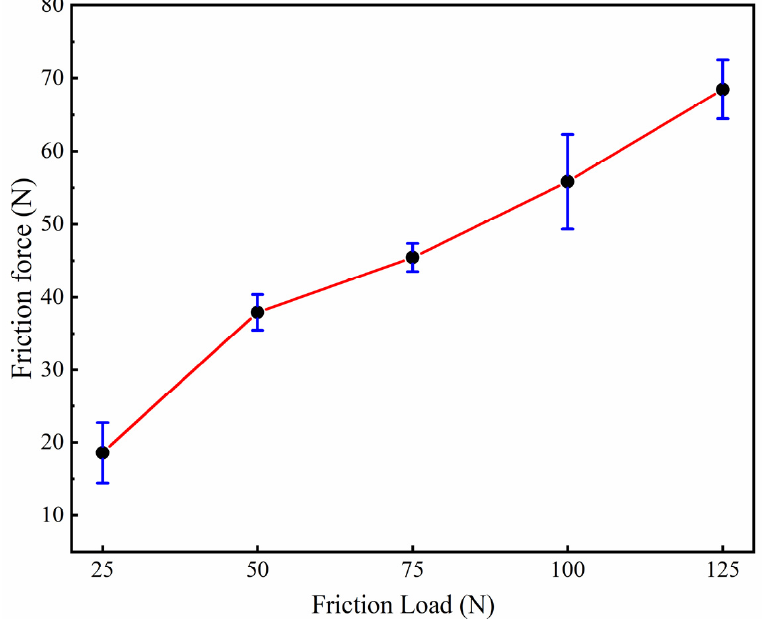
Figure 10. The curve of the mean frictional force and frictional load of sample YG8-10 (the points represent the frictional forces of the sample YG8-10 under different loads; the error value of the frictional force is shown in green; red indicates the shift curve between the load and frictional forces).